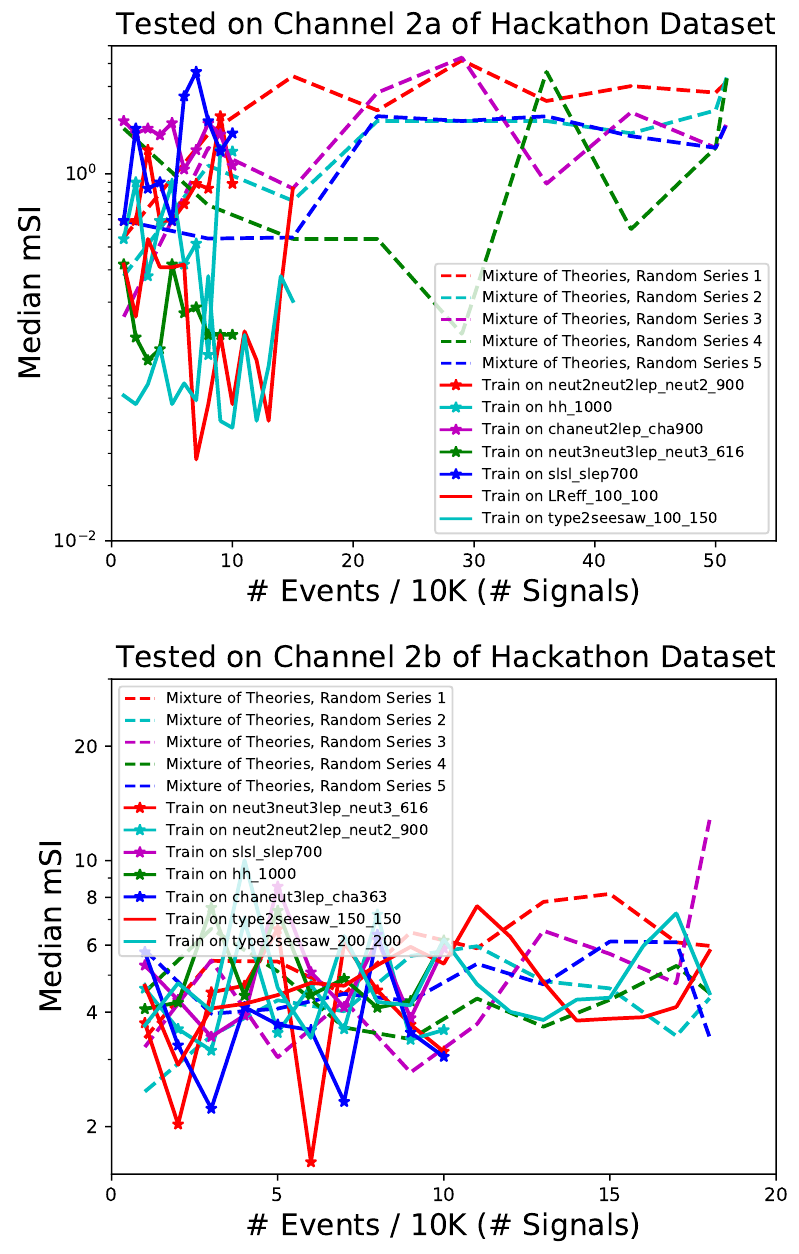
Figure 7 . The figure shows the median values of the maximum significance improvements for all test signals from trained models for channels with leptonic final states tested with signals from the hackathon data . For the dashed line, the training processes based on an increasing number of signals with a point size of 10000 are repeated 5 times per channel in random series. The steps to add signals to the training set are (7, 2) for (channel 2a, channel 2b), while all channels start with the model with only one signal in the training set. For the star-shaped lines, we use only 1 single signal and gradually increase the number of events in steps of 10000. The solid lines are similar to the star lines trained with a single signal. However, additional events are generated to extend the